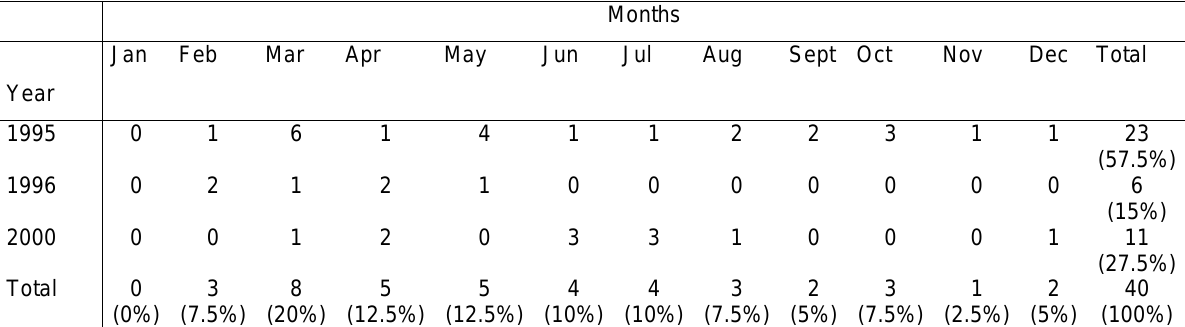
Table 1: Frequency of envenomations by Bothrops snakes in Northwest counties of the Rio de Janeiro State, Brazil, in 1995, 1996 and